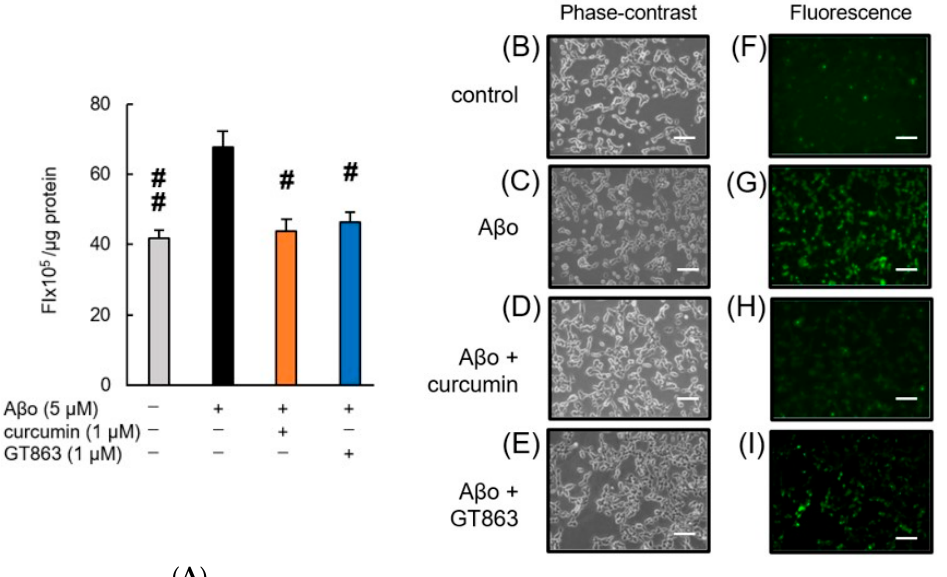
Figure 5. Effect of curcumin and GT863 on ROS generation in A β o − stimulated SH − SY5Y cells. ( A – I ) ROS generation in A β o − stimulated SH − SY5Y cells was evaluated using CM − H 2 DCFDA. ( A ) ROS generation in SH − SY5Y cells exposed to 5 μ M A β o and treated with A β o + curcumin or A β o + GT863.